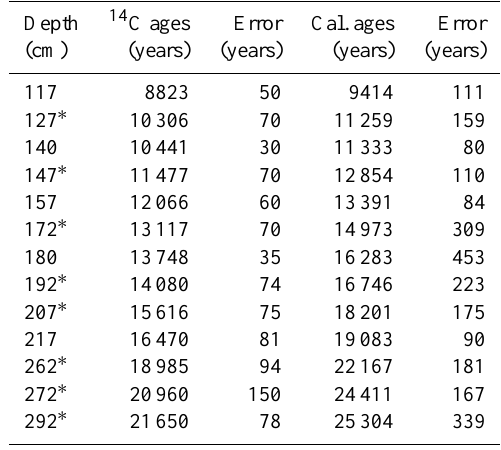
∗ Samples were measured in the NSF-Arizona AMS Laboratory of the University of Arizona (U. Arizona), Tucson, USA, and the others were measured in the Rafter Radiocarbon Laboratory, Institute of Geological and Nuclear Science (GNS), New